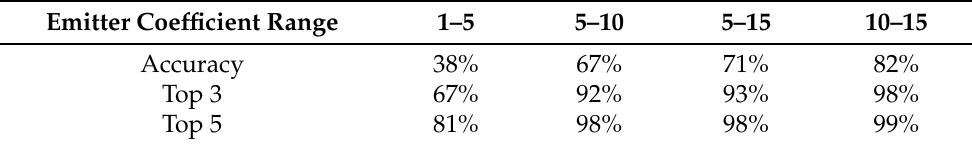
Table 4. Influence of emitter coefficient variation on model accuracy for the Hanoi network with a demand variation of ± 2.5% with 500,000 inputs.